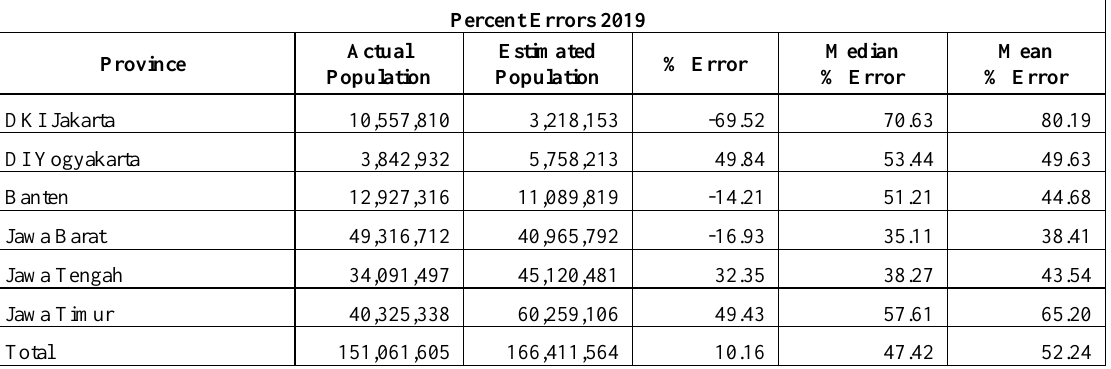
Table 5. Percent errors of the 2019 population estimates per